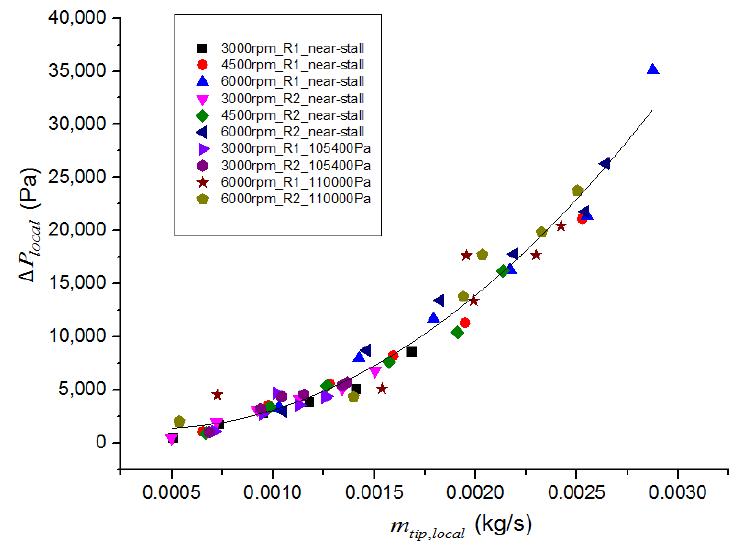
Figure 7. Relationship between local load difference and local leakage flow.